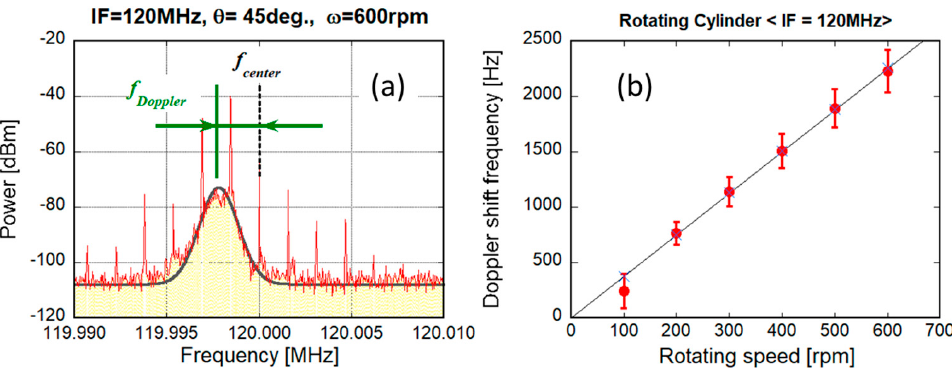
Figure 10. ( a ) Example of frequency spectrum of signal scattered from rotating drum whose rotating speed is 600 rpm. Black line is result of Gaussian fitting. ( b ) Estimated Doppler shift frequency as function of rotating speed of drum. Black dotted line is the line estimated from equation f D = r ω · 2 k sin θ /2 π .